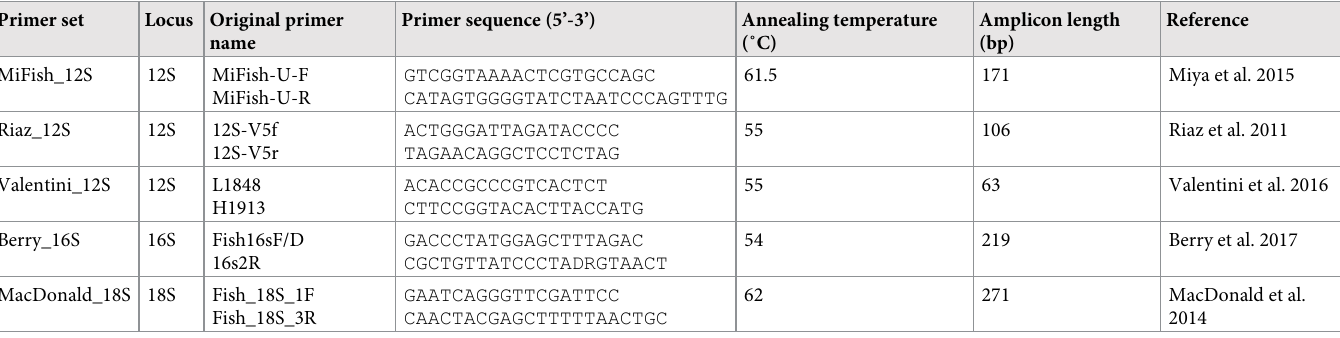
Table 1. Primer sets used in this study including primer sequence, annealing temperature used for PCR1, and expected average amplicon length. Primer